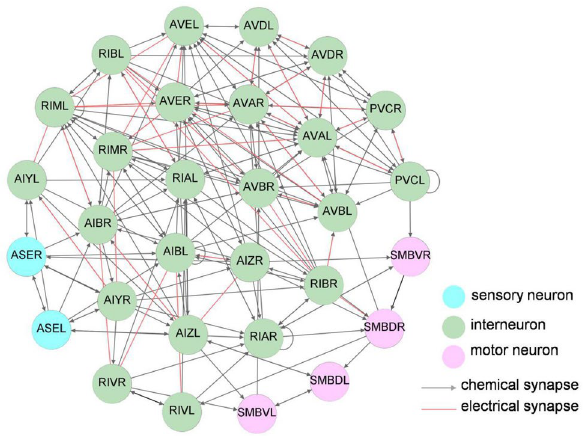
Figure 8. Architecture of the neural network model regarding chemotaxis in C.